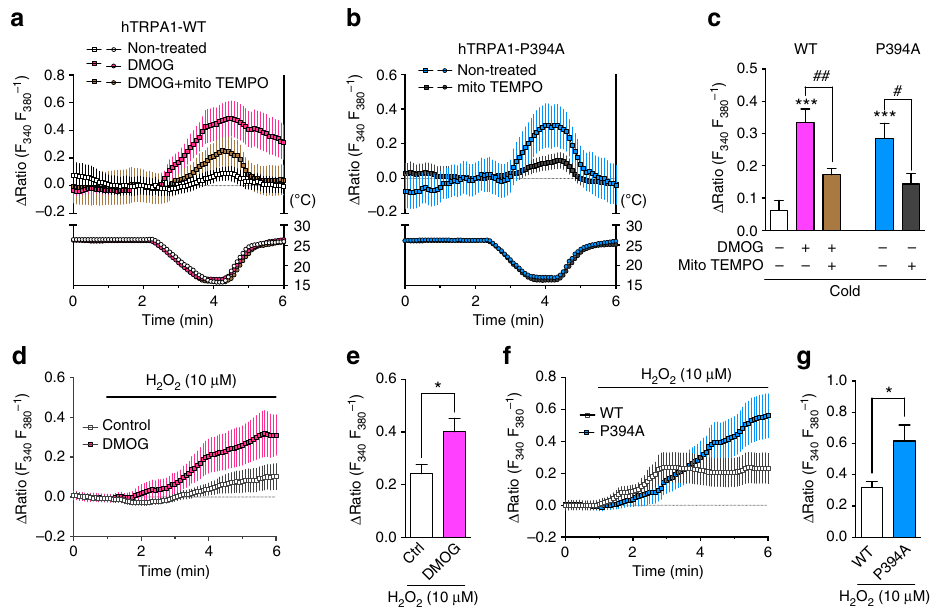
Figure 2 | Enhanced response to ROS induced by relief from prolyl hydroxylation mediates cold sensitivity of hTRPA1. DMOG-pretreated hTRPA1-WT- or hTRPA1-P394A-expressing cells were exposed to cold ( a – c ) or 10 m M H 2 O 2 ( d – g ) and analysed using Ca 2 þ imaging experiments. ( a – c ) Representative traces of cold-induced [Ca 2 þ ] i responses in hTRPA1-WT-expressing cells pretreated with or without 100 m M DMOG for 2h ( a , n ¼ 7–20 cells) and hTRPA1-P394A-expressing cells ( b , n ¼ 11–16 cells) with or without 10 m M mitoTEMPO pretreatment, and statistical analysis ( c , n ¼ 45–75 cells). *** P o 0.001 versus non-treated hTRPA1-WT (white bar); # P o 0.05, ## P o 0.01; one-way ANOVA with Tukey’s post hoc test. ( d , e ) Representative traces of 10 m M H 2 O 2 -evoked [Ca 2 þ ] i responses in hTRPA1-WT-expressing cells pretreated with vehicle (control) or 100 m M DMOG for 2h ( d , n ¼ 47–55 cells), and statistical analysis ( e , n ¼ 4–8). * P o 0.05; unpaired t test. ( f , g ) Representative traces of the [Ca 2 þ ] i response evoked by 10 m M H 2 O 2 in hTRPA1-WT- or hTRPA1-P394A-expressing cells ( f , n ¼ 43–46 cells), and statistical analysis ( g , n ¼ 5–6). * P o 0.05; unpaired t test. All data are expressed as mean ± s.e.m. Ctrl,